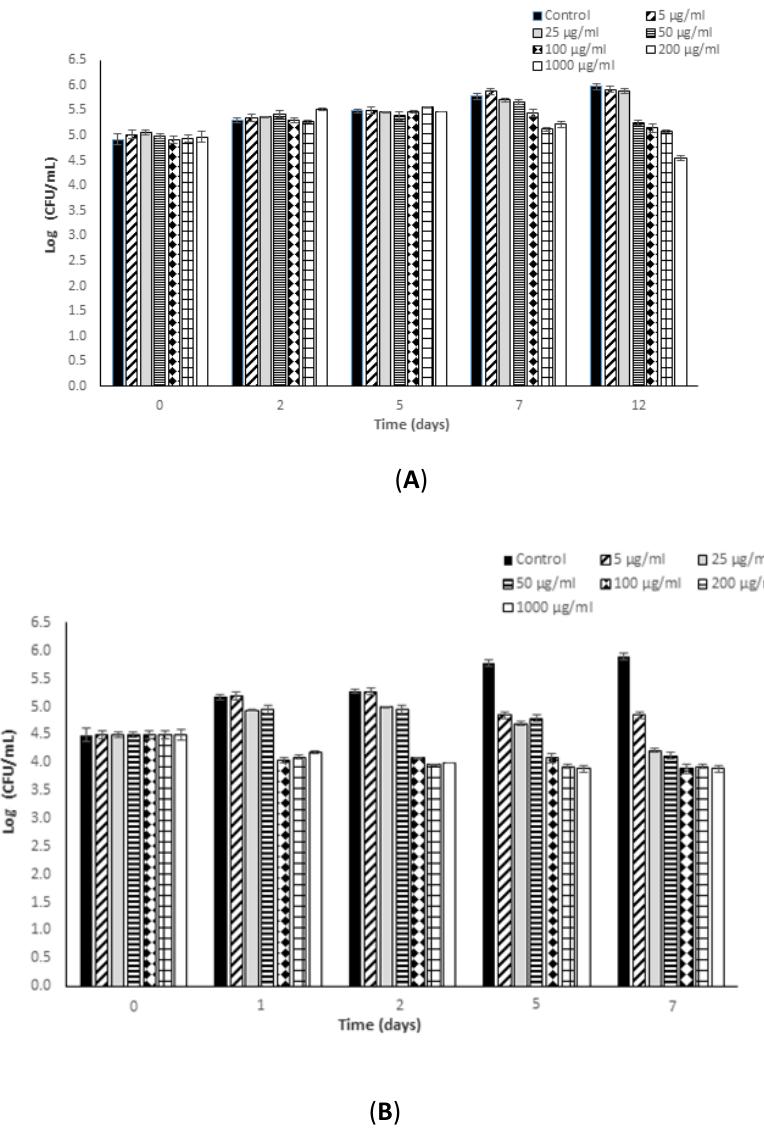
Figure 1. Kinetic results (log (CFU/mL) versus time (days)) obtained in the determination of the in vitro antimicrobial potential of fucoidan against Listeria monocytogenes in reference medium, Mueller Hinton Broth (MHB). ( A ) 8 °C (12 days); ( B ) 37 °C (7 days).